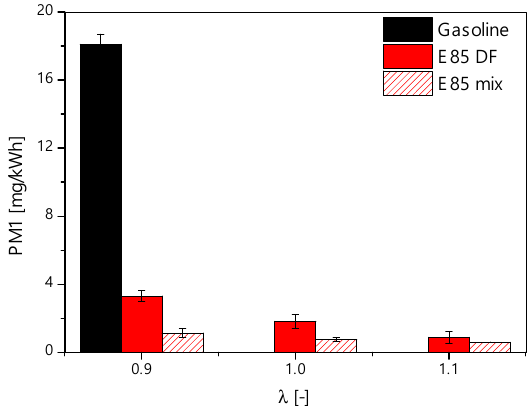
Figure 17. PM 1 estimated by PN size distribution.